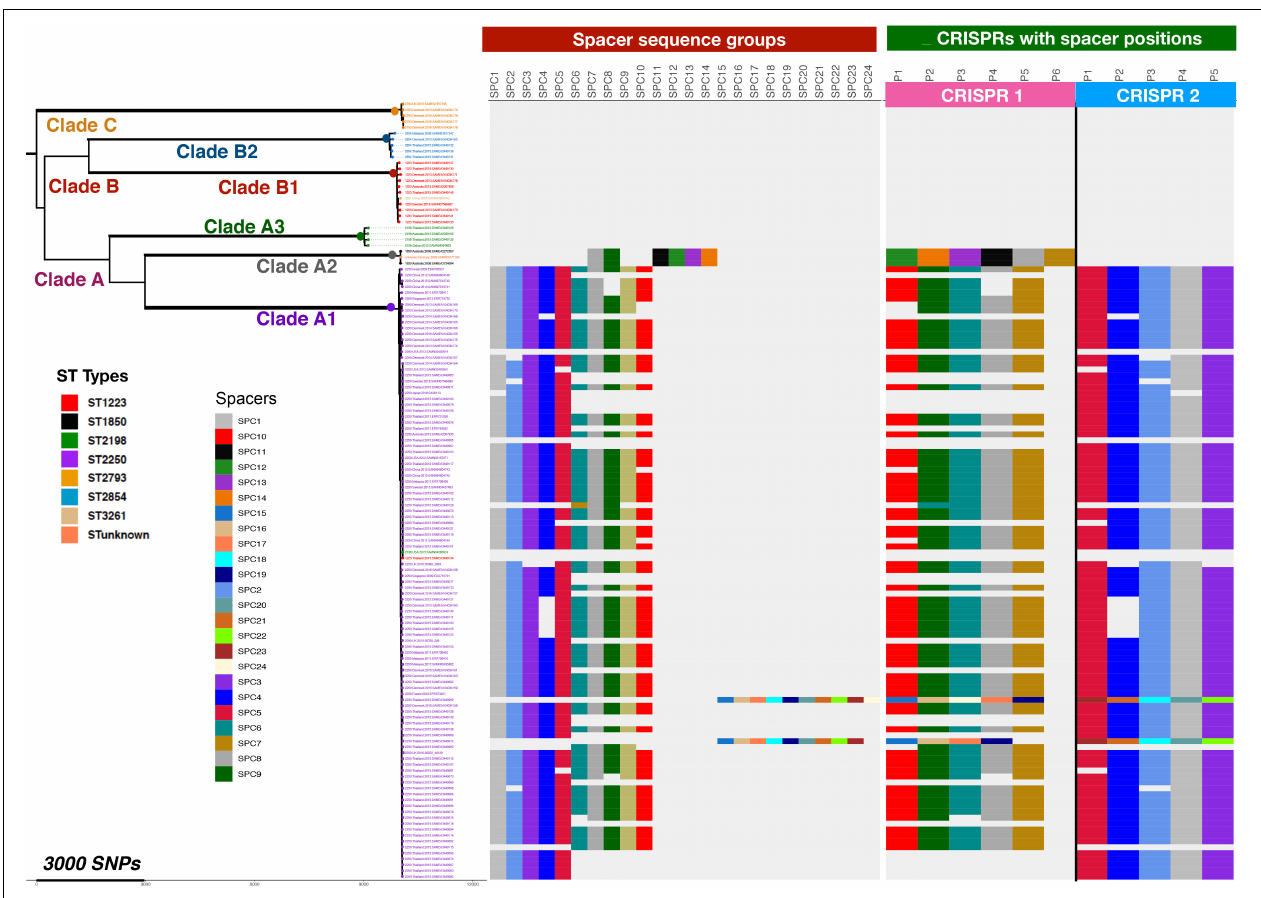
FIGURE 8 | Distribution of Phage and Plasmid spacer sequences in strains of S. argenteus. Phage and plasmid derived spacer sequences within CRISPR/Cas repeats of different strains of S. argenteus are shown, grouped as defined in Supplementary Table 1 and arranged according to the phylogenetic relationships of the different strains as shown in Figure 2 . The left hand panel shows the occurrence of the different sequence spacer groups in the different strains. The right hand panel shows the location of the spacers within the two CRISPR/Cas spacer groups. Spacer positions are designated P1, P2, etc, as they are found in the CRISPR/Cas locus, starting with P1 at the left hand end of the spacer regions as shown in Figure 7